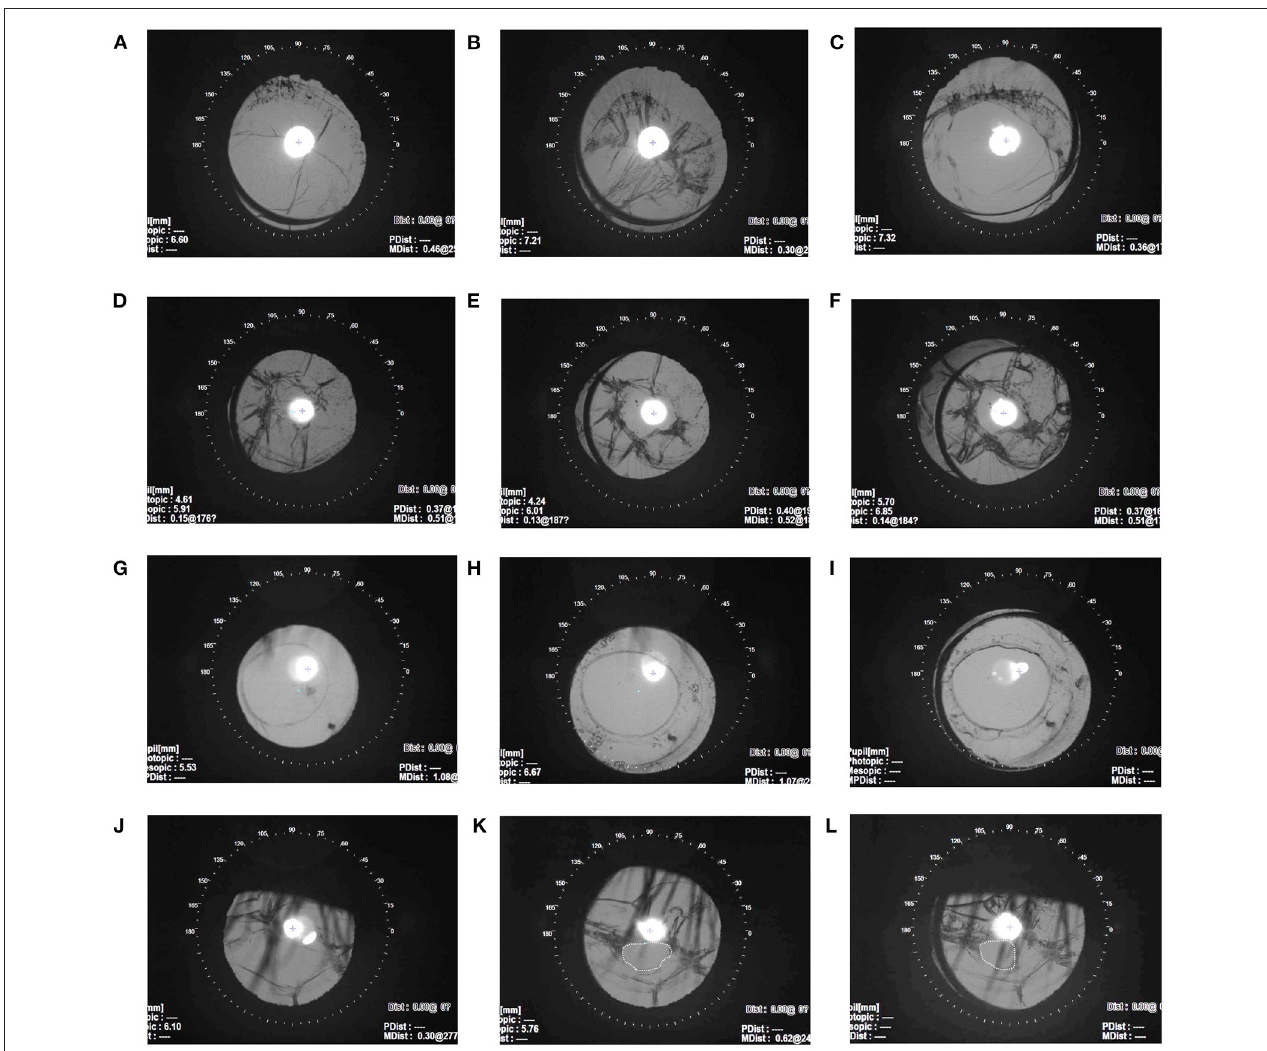
FIGURE 4 | Postoperative capsule change in the SCSF-IOL group. (A–C) The retro illumination images show residual capsule postoperative changes in the same MSP eye. The capsule was clear and flat 1 week after surgery (A) and contracted 1-month postoperatively (B) . After laser treatment for 1 month, the contraction was ameliorated, and the visual axis was clear (C) . (D–F) Capsule changes in the same MSP eye 1 day before Nd:YAG laser capsulotomy (D) and 1 month after laser treatment (E) . The opening remained centered, and the BCVA achieved 0.0 LogMAR at 1-year follow-up (F) . (G–I) A 5-year-old boy with MSP underwent regional posterior capsulotomy and limited anterior vitrectomy during the surgery. The capsule remained stable at the 1-week (G) , 6-month (H) , and 9-month (I) follow-up visits. (J–L) A 12-year-old girl with MSP had an unexpected decentered posterior capsulorhexis opening (dashed circle). The retro illumination images show the capsule before laser treatment (J) . The posterior capsule opening was decentered 5 months after laser capsulotomy (K) and 1 year after surgery (L) . The BCVA was 0.4 LogMAR at 1-year follow-up. BCVA, best-corrected visual acuity; SCSF-IOL, supra-capsular and scleral-fixated intraocular lens implantation; LogMAR, logarithm of the minimal angle of resolution; MSP,